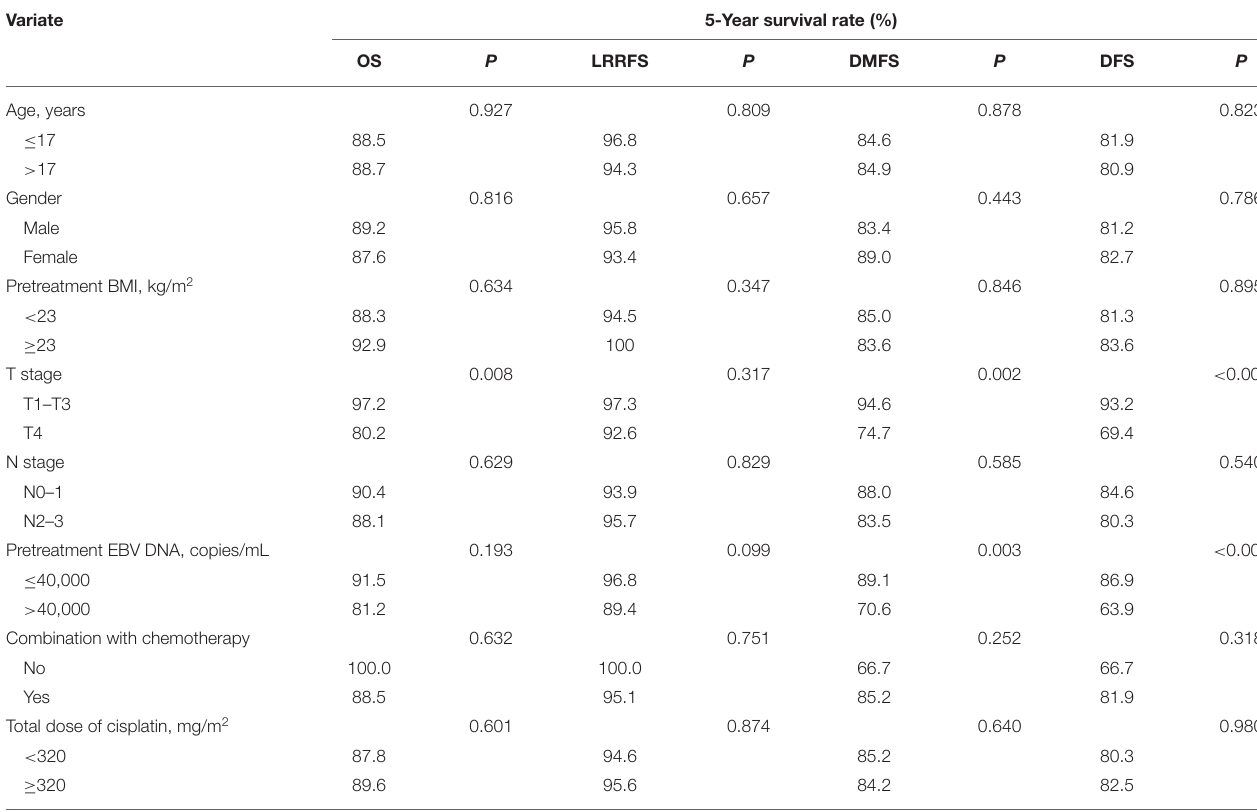
TABLE 4 | Univariate analysis of prognostic factors for 147 patients.